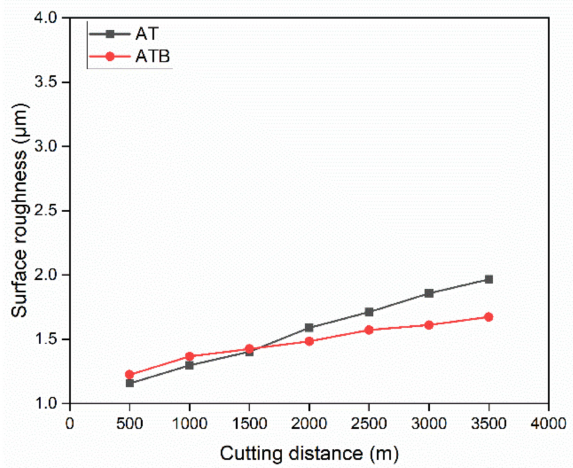
Figure 11. Surface roughness of different cutting tools.